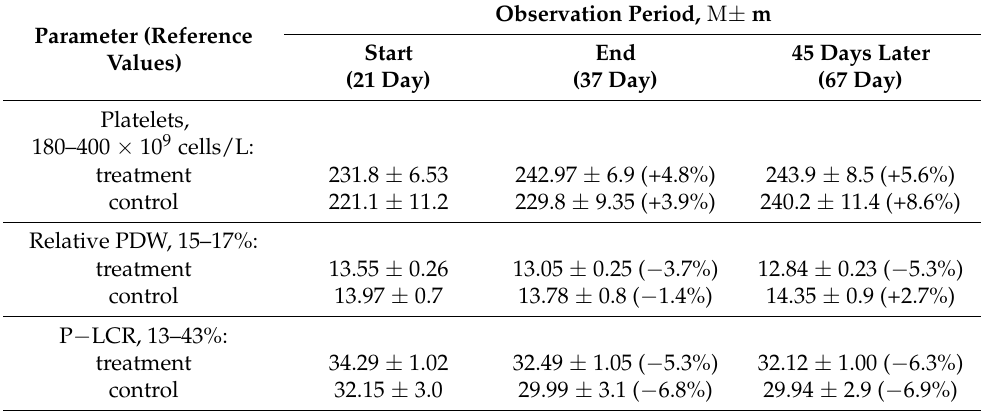
Table 8. Platelets during the food intervention (absolute